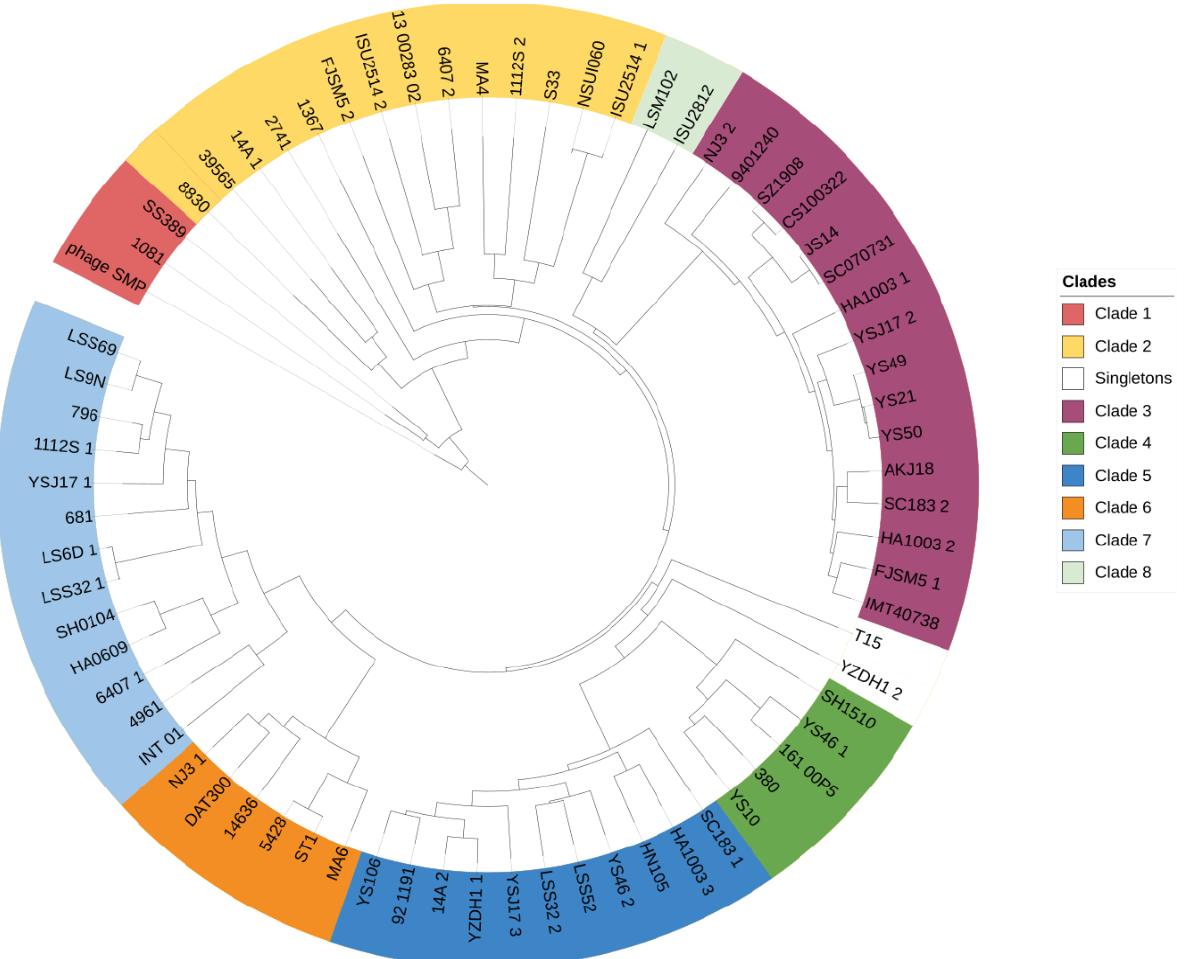
Figure 5. Phylogenetic tree of S. suis (pro)phages. Tree was constructed from DNA sequence of the 71 full-length prophages with phage SMP as root. Computations of distance matrix and proteomic tree generation were performed in ViPtree. The final tree was visualised using iTOL. Clades are shown in different colours .